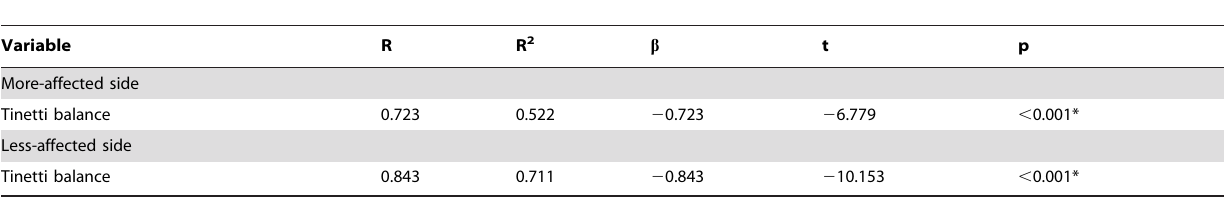
Table 3. Summary of linear